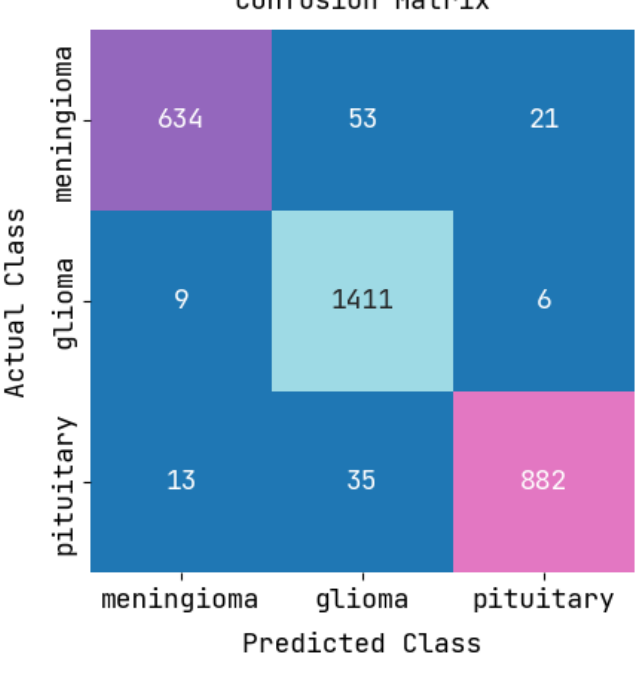
Figure 5. Confusion matrix.